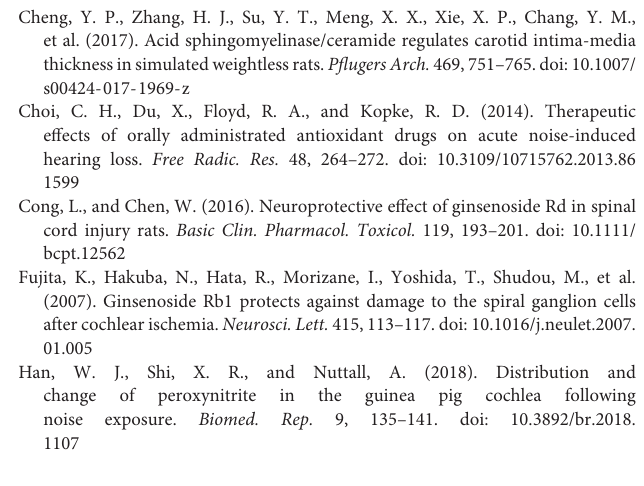
FIGURE S1 | Percentage figure: GO enrichment analysis of GSRd from STITCH database. FIGURE S2 | GO enrichment analysis of GSRd from STITCH database. FIGURE S3 | KEGG enrichment analysis of GSRd from STITCH database. FIGURE S4 | Volcano plot of differentially expressed genes after SIRT1 activation. TABLE S1 | Gene ontology and pathway enrichment analysis of the up-regulated and down-regulated